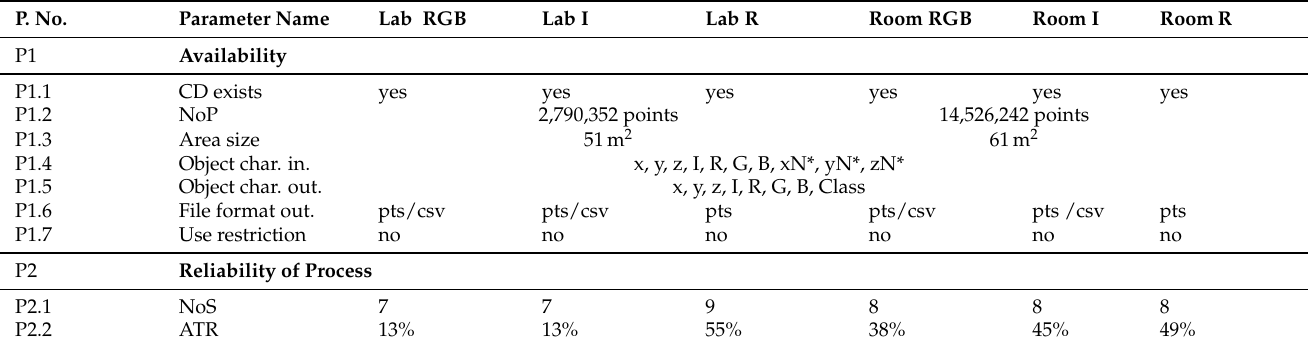
Table 12. Calculated and determined values for the quality parameters of availability and reliability of process. Object parameters with * are calculated in the segmentation